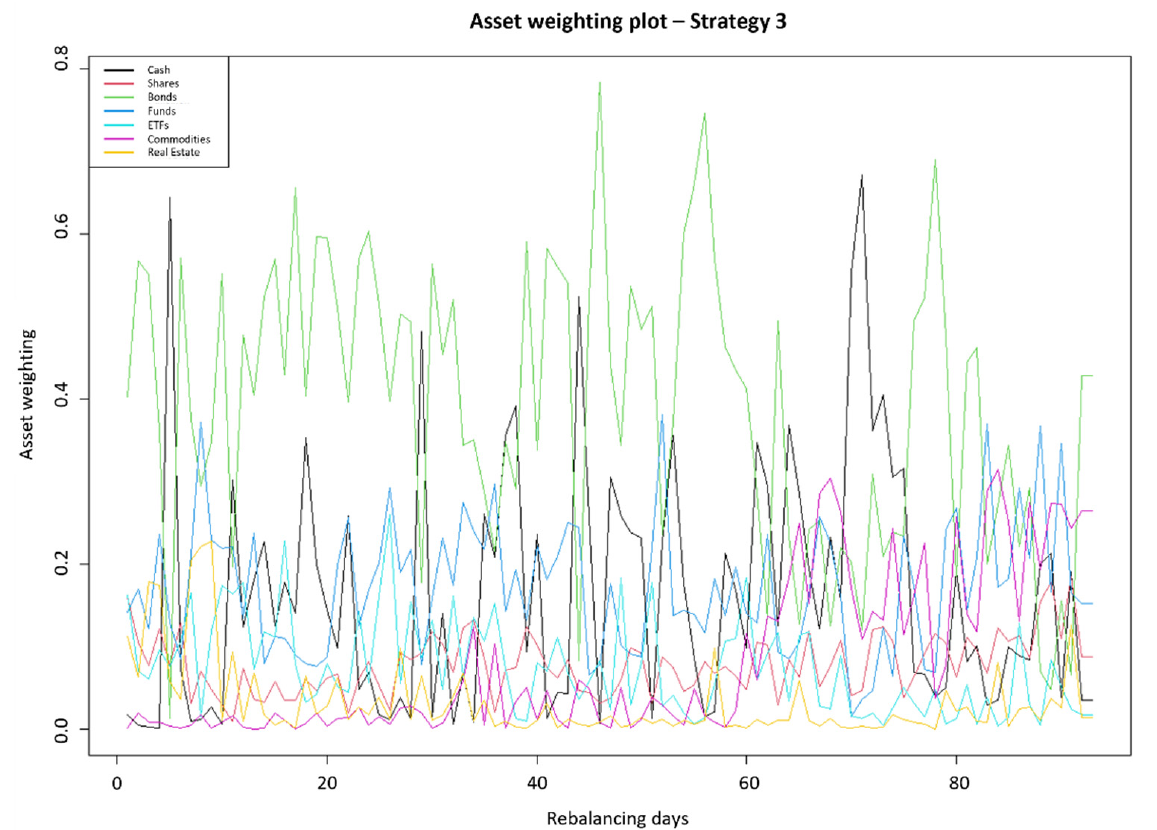
Figure 8. The asset weights plot of Strategy 3 .